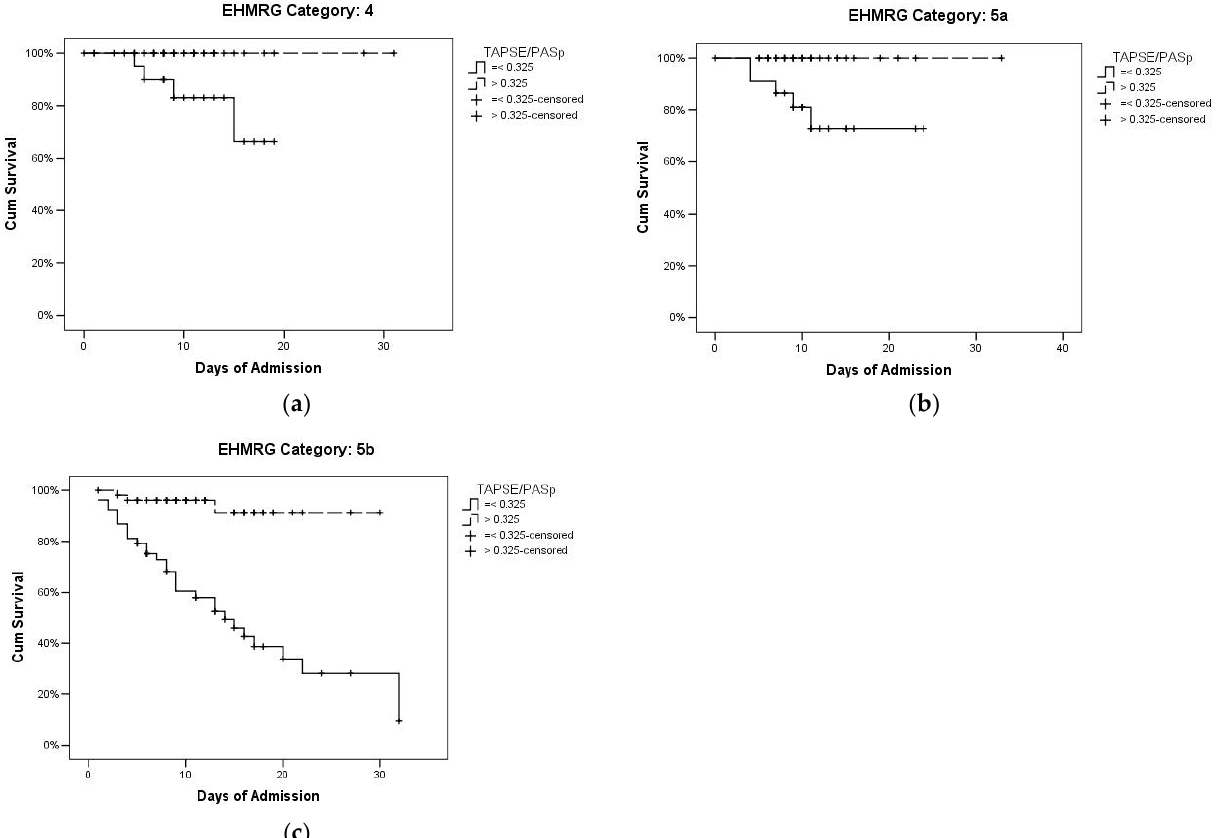
Figure 5. Kaplan –Meier’s curves of survival for TAPSE/PASp in ( a ) EHMRG category 4 ( p = 0.010, log-rank test); ( b ) EHMRG category 5a ( p = 0.010, log-rank test), ( c ) EHMRG category 5b ( p < 0.0001, log-rank test). Table 3. Cox regression analysis